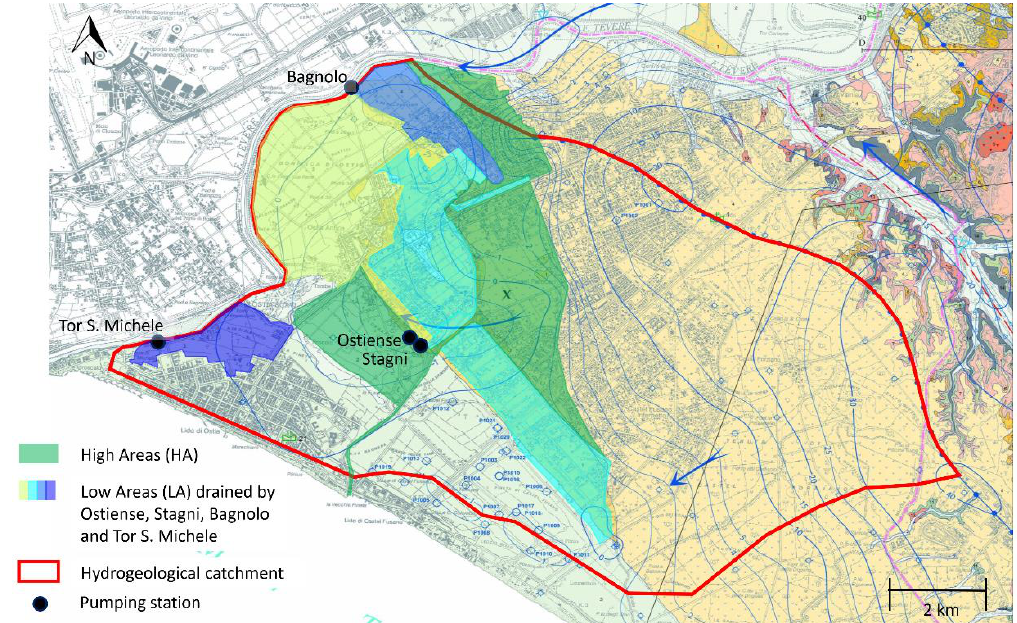
Figure 3. Hydrogeological map of the area (derived from Reference [34]), which shows the (surface) catchment size of the low areas (colored areas) for the different pumping stations (circles) together with the boundary (red line) of the groundwater basin, as inferred from the iso-piezometric lines.